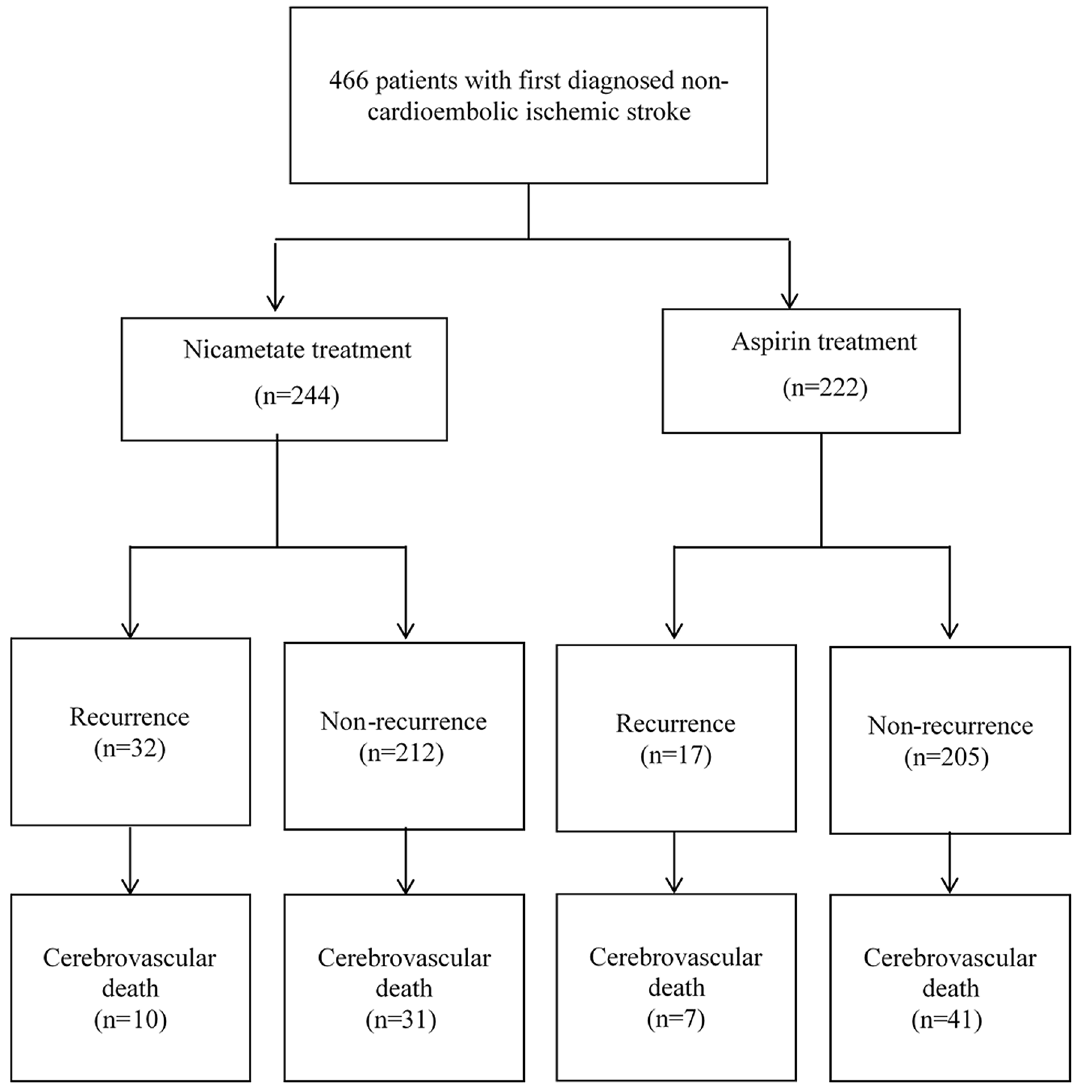
Figure 3. The follow-up of stoke recurrence and cerebrovascular